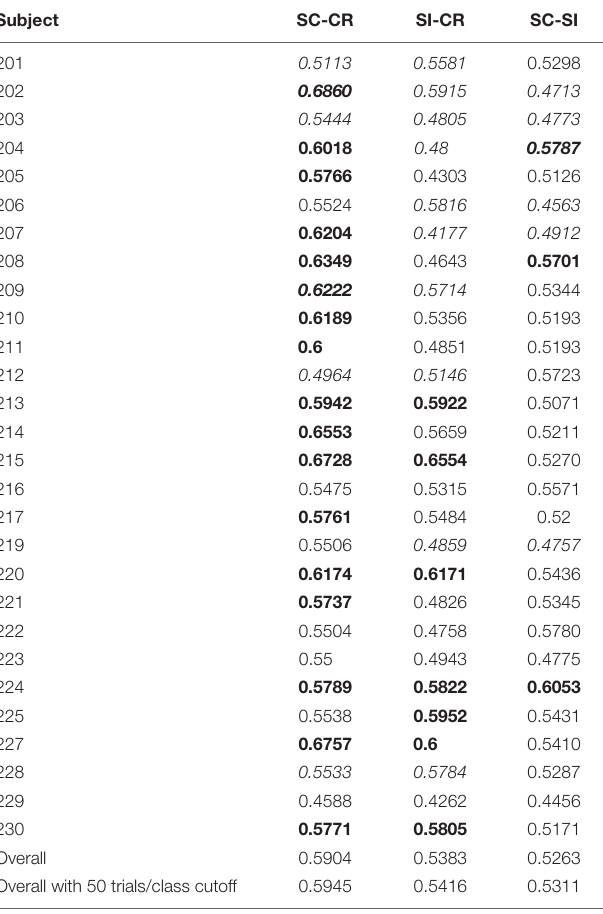
TABLE 1B | Classification results for Experiment